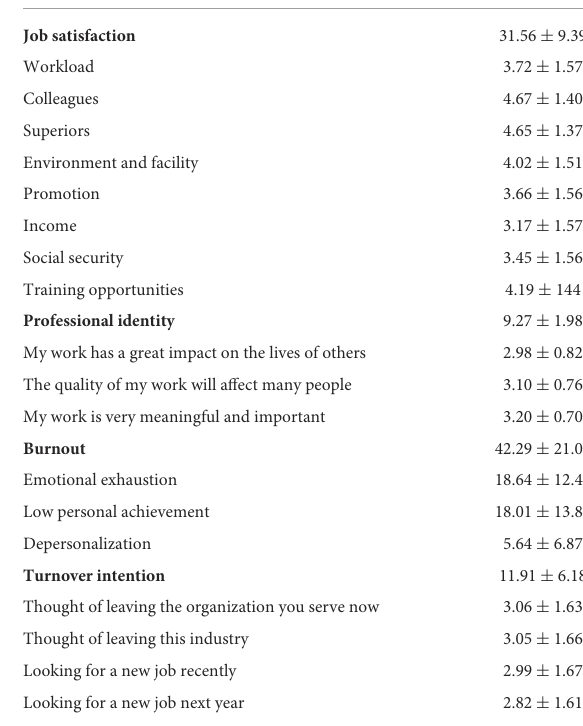
burnout, and turnover intention.